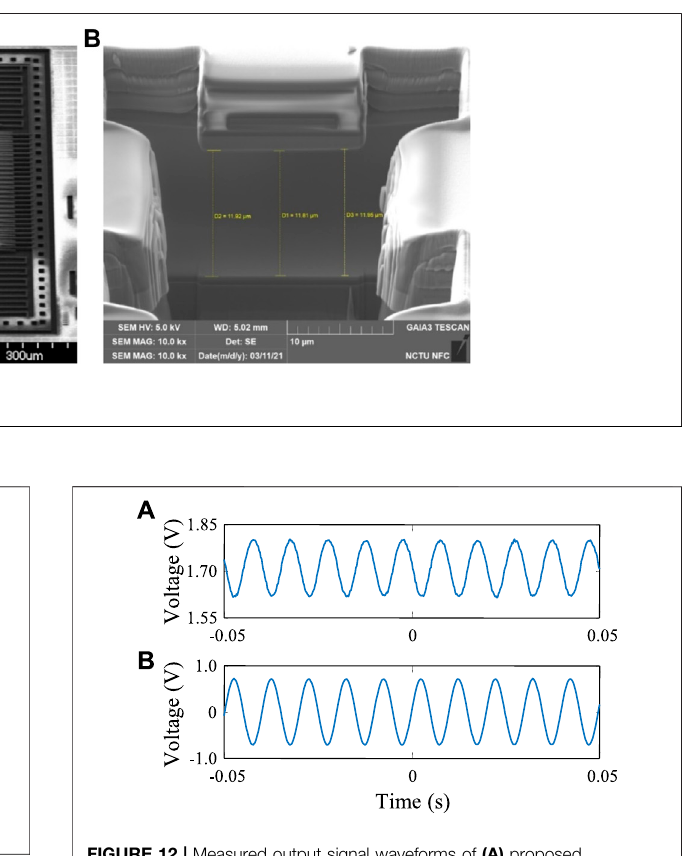
FIGURE 12 | Measured output signal waveforms of (A) proposed accelerometerand (B) commercialaccelerometerfor f in =100 Hz, a ext =5g rms and V p = 0